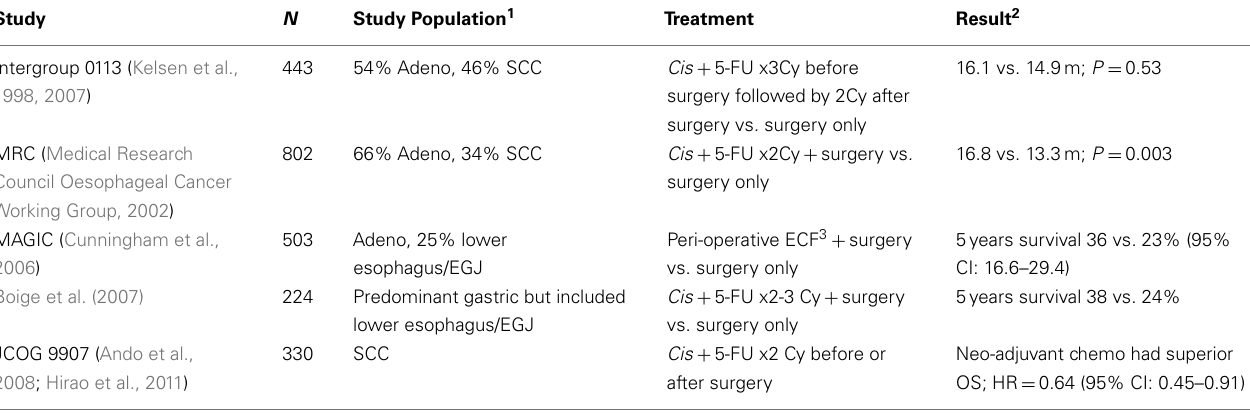
Table 1 | Phase III studies using neo-adjuvant